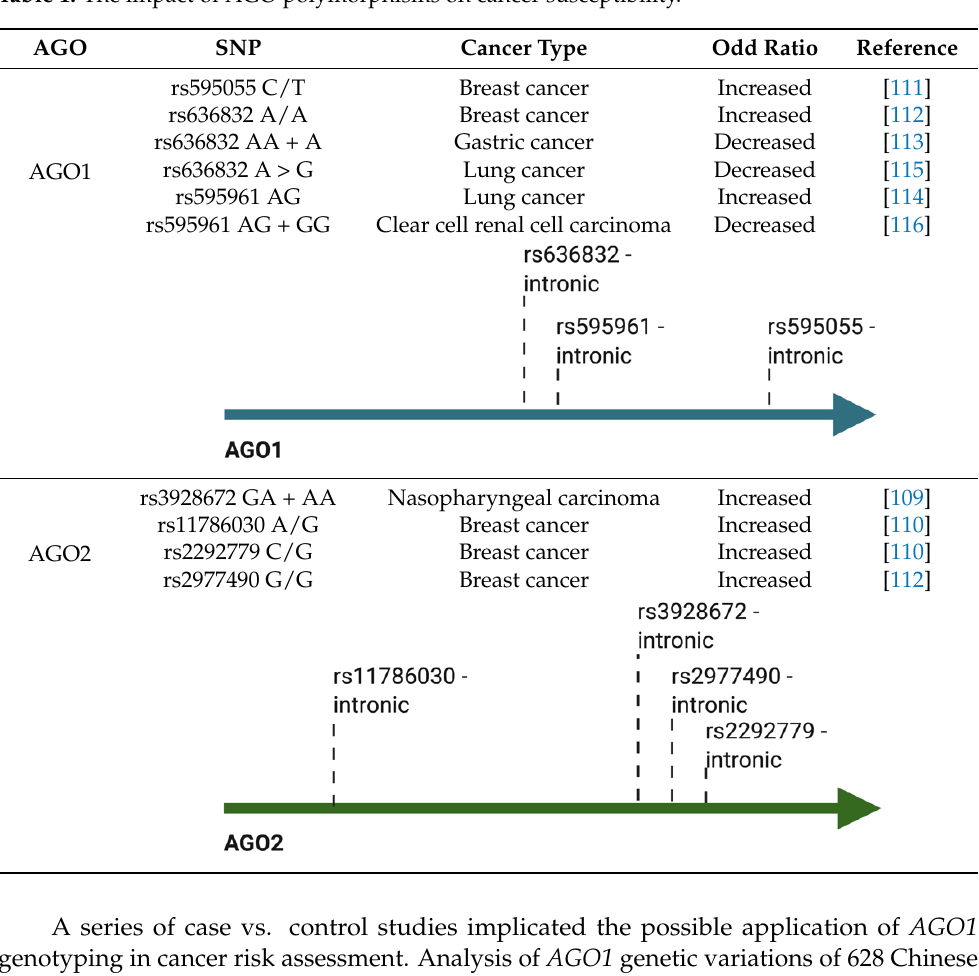
Table 1. The impact of AGO polymorphisms on cancer